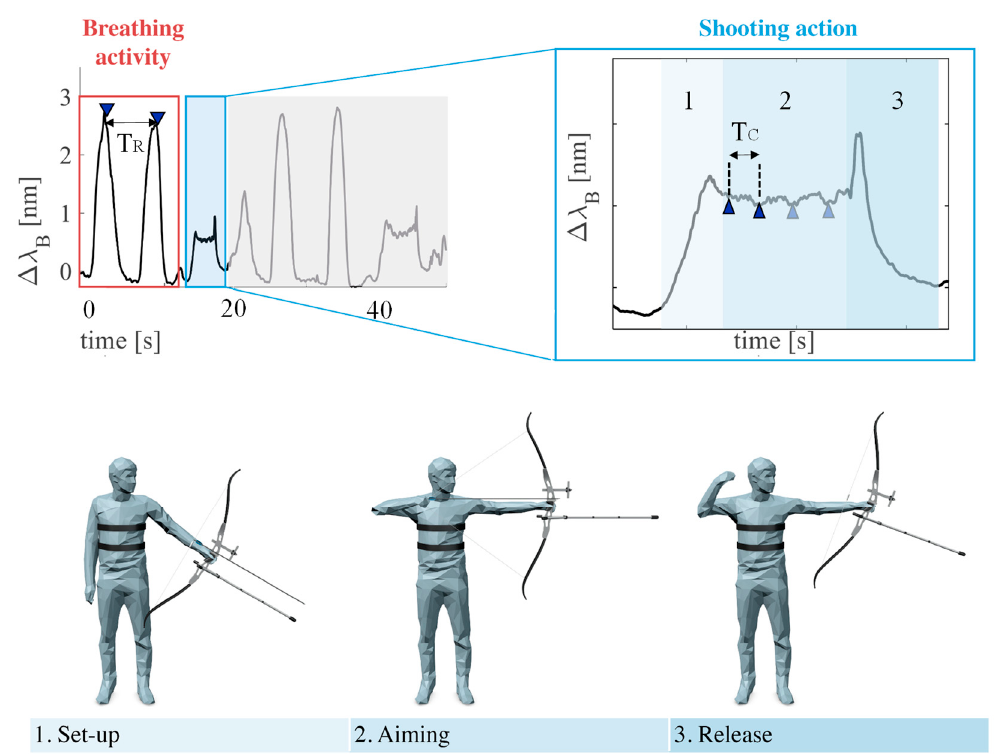
Figure 11. Output of the sensor changes during both breathing activity and shooting action. Table 5. Values of f R and HR during the first and the second shooting sessions. Shooting Session #1 Shooting Session #2